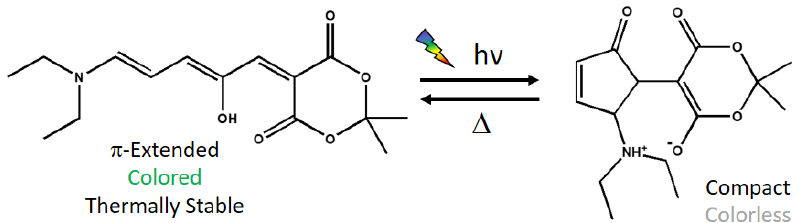
Figure 1. Switching mechanism of the donor–acceptor Stenhouse adducts (DASA) derivative under study. The opened state ( left ) is irradiated to form the closed state ( right ). Thermally, the closed state reverts to the opened state.